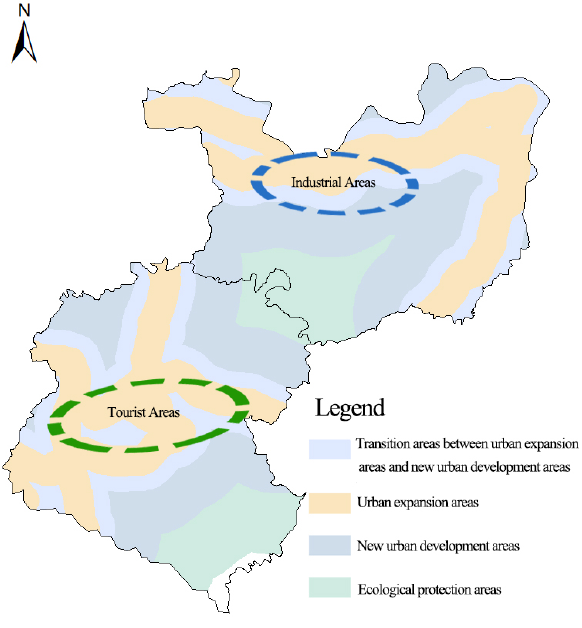
Figure 3. The buffer of road networks.